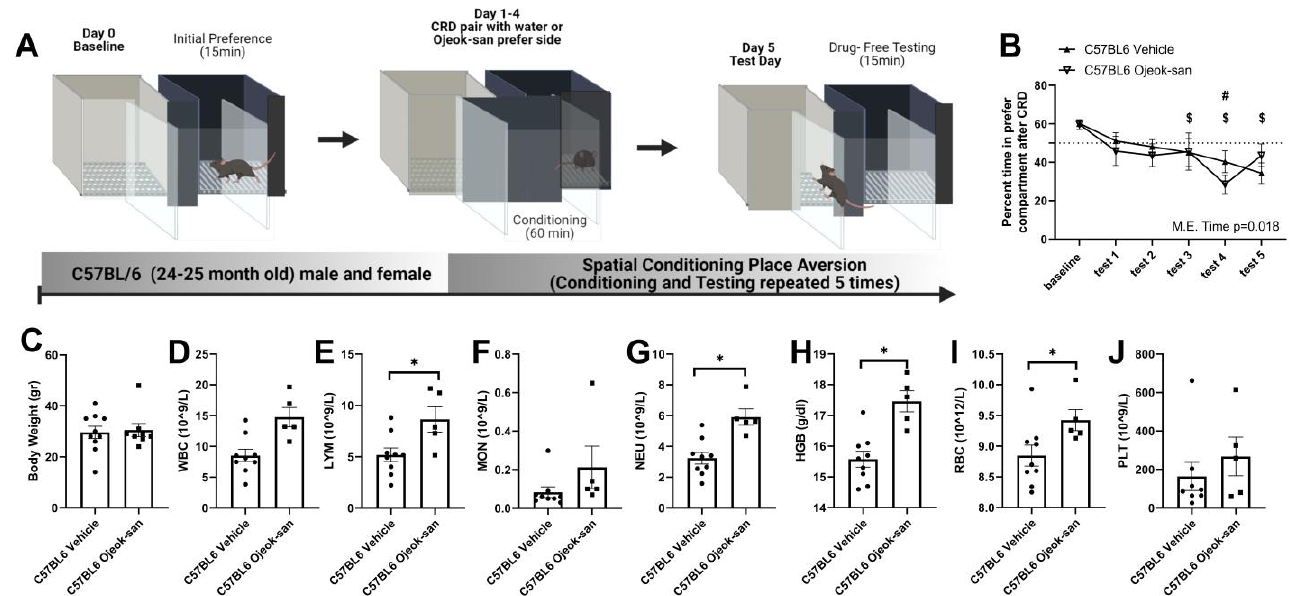
Figure 9. OJS reduces aversive behavior produced by colorectal balloon distension in C57BL6 mice. ( A ) Graphical depiction of spatial conditioning place-aversion protocol, ( B ) percentage of time spend in the preferred (non-OJS-paired side) compartment during the test sessions, ( C ) body weight, ( D ) WBC, ( E ) LYM, ( F ) MON, ( G ) NEU, ( H ) RBC, ( I ) HGB, and ( J ) PLT in vehicle- and OJS-treated C57BL6 mice. Values are represented as mean ± SEM; n = 7–10 mice per group. Two-way RM AVOVA for B. $ Indicates statistical significance from baseline in C57BL6 Vehicle mice. # Indicates statistical significance from baseline in C57BL6 OJS-treated mice. Two-tail unpaired t -test for ( C – J ), * p < 0.05.